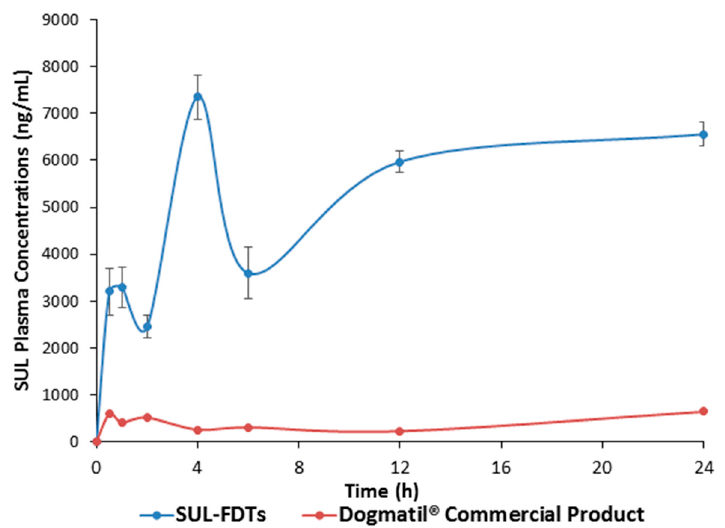
Figure 5. Plasma concentration—time profile of SUL for both SUL-FDT and Dogmatil ® commercial product after administration of optimized SUL-FDT formulation and Dogmatil ® to male Newzealand rabbits ( n = 5, each value is the average ± S.D.).